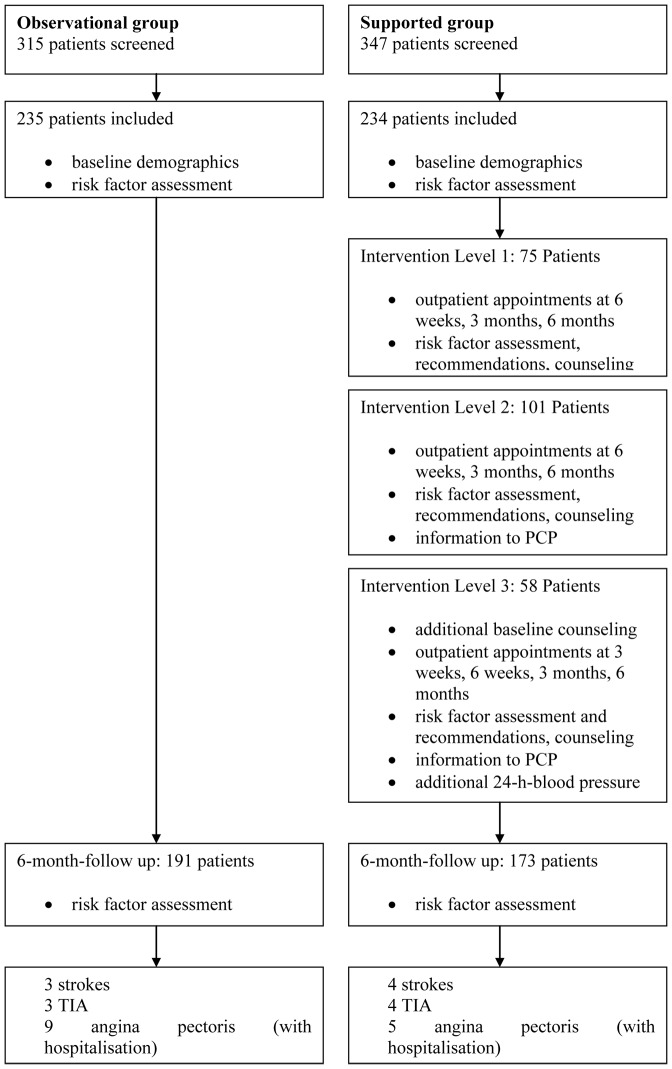
Study flow chart.